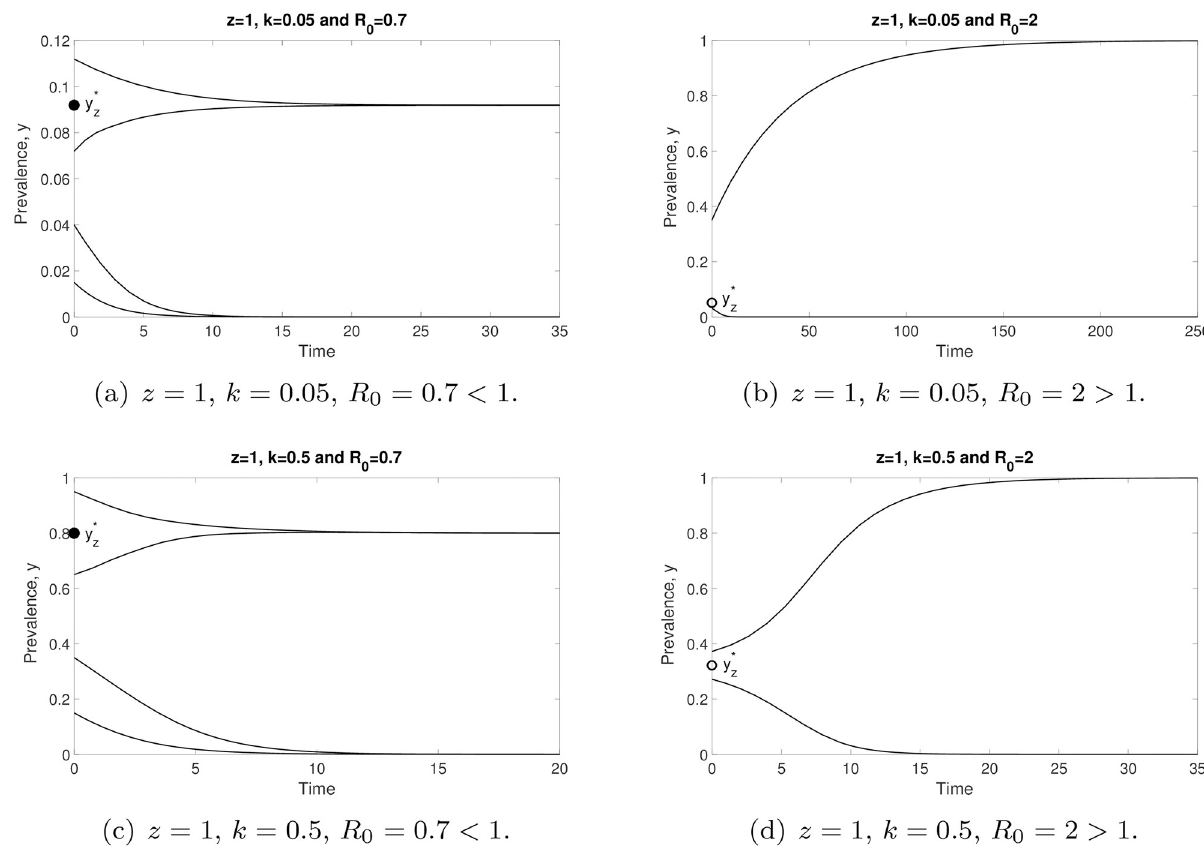
Fig 13. The dynamics of the model (18) with arbitrary k , R 0 and initial values. Parasite extinction is possible if the initial value of y is sufficiently low. Otherwise, the disease will remain endemic.